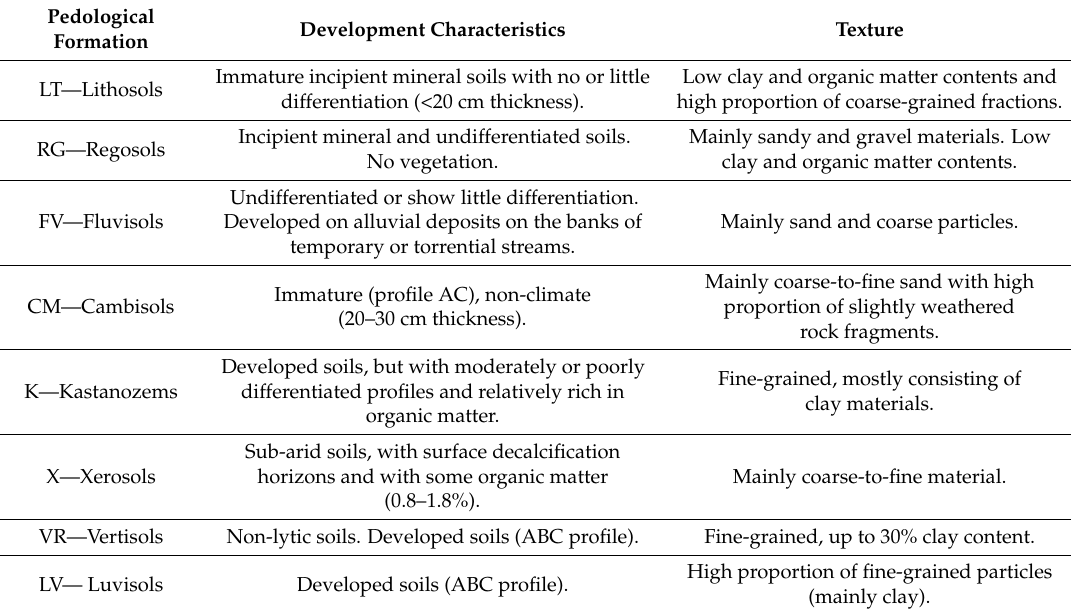
Table 2. Brief description of each group of the soils of Santiago